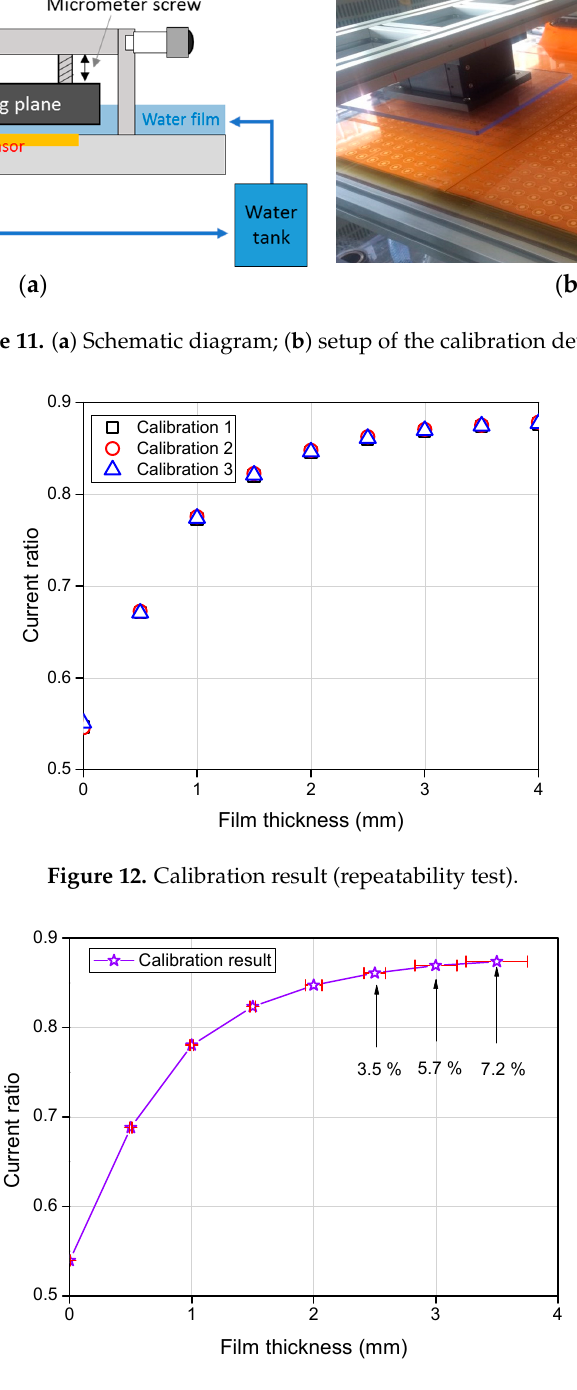
Figure 13. Calibration curve with spline interpolation.